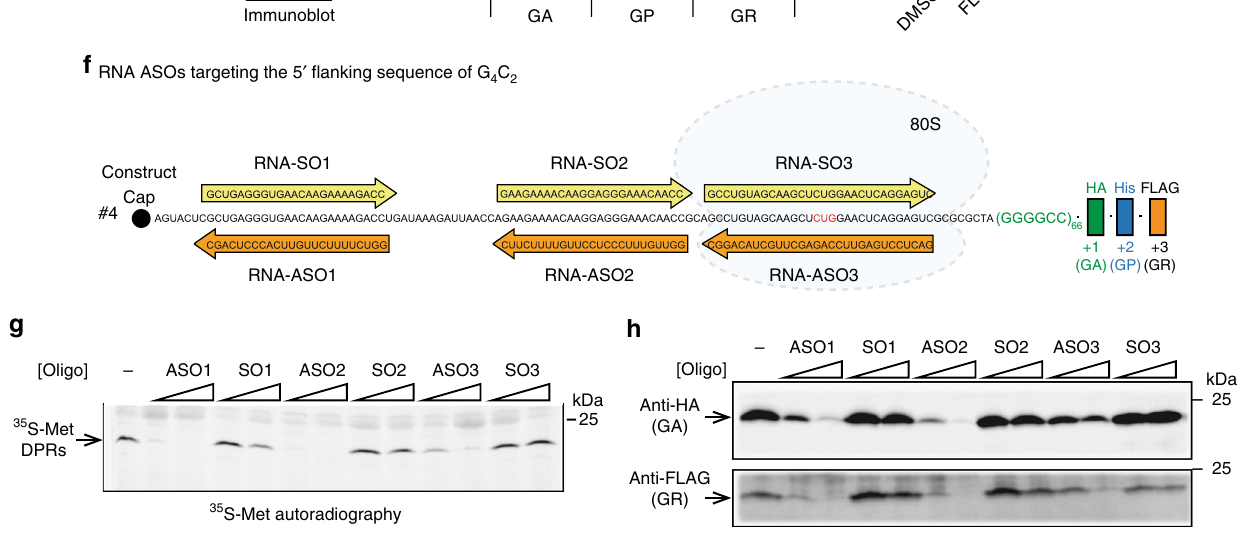
the ribosome independently from DPR translation, we performed sucrose gradient analysis with puri fi ed ribosomal 40S and 60S. Expanded transcripts with 30 repeats were able to recruit and load several 40S and 60S ribosomal subunits without the need of 5 ′ -cap and any other initiation factors (Fig. 7e). Overall, we demonstrate here that G 4 C 2 repeat-containing transcripts associate with ribosomal subunits independently of translational factors.